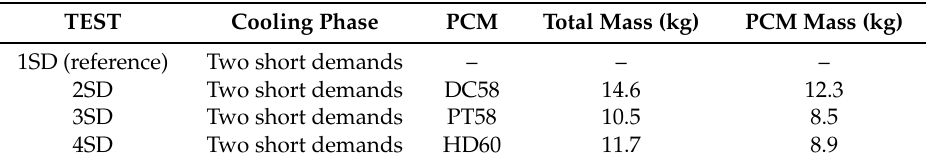
Table 5. Tests presented simulating two short